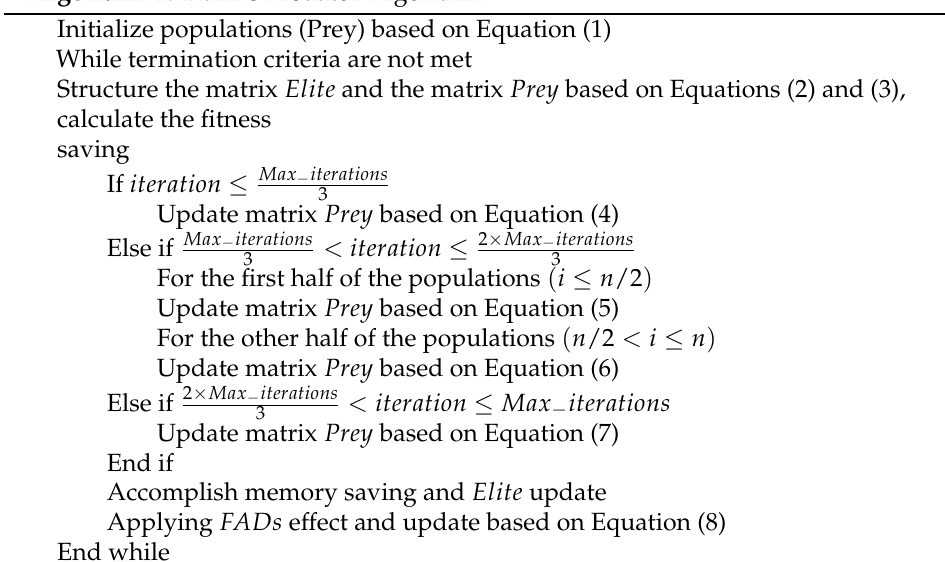
Algorithm 1: Marine Predator